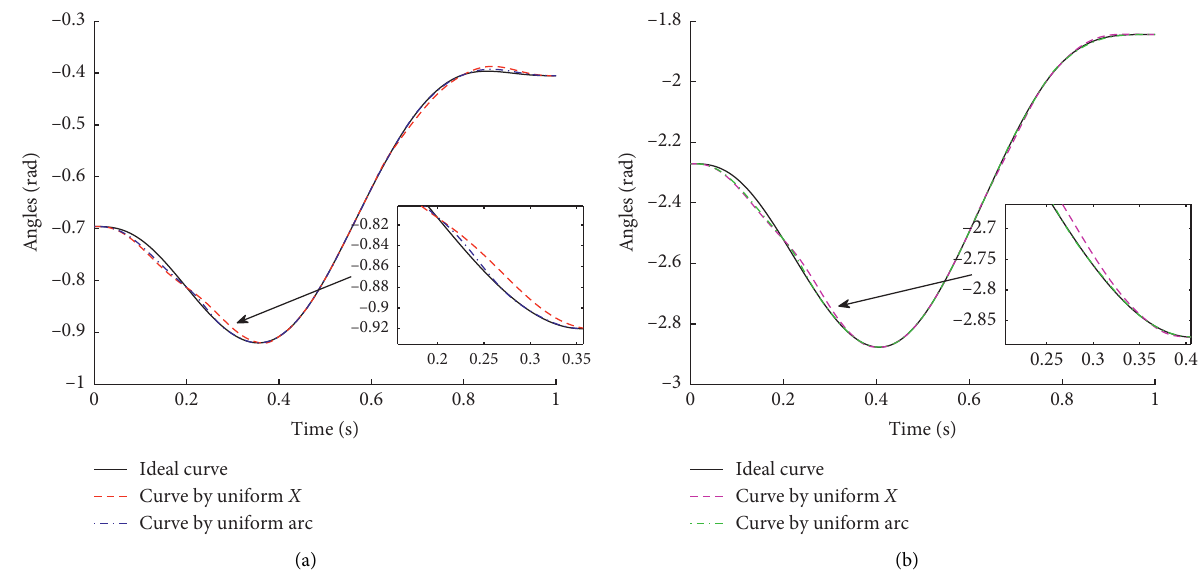
Figure 9: Joint trajectory effect based on spatial divisions. (a) HFE joint trajectory. (b) KFE joint trajectory. Table 5: Corresponding trajectory points of uniform time. Point number Time (s) X position (mm) Y position